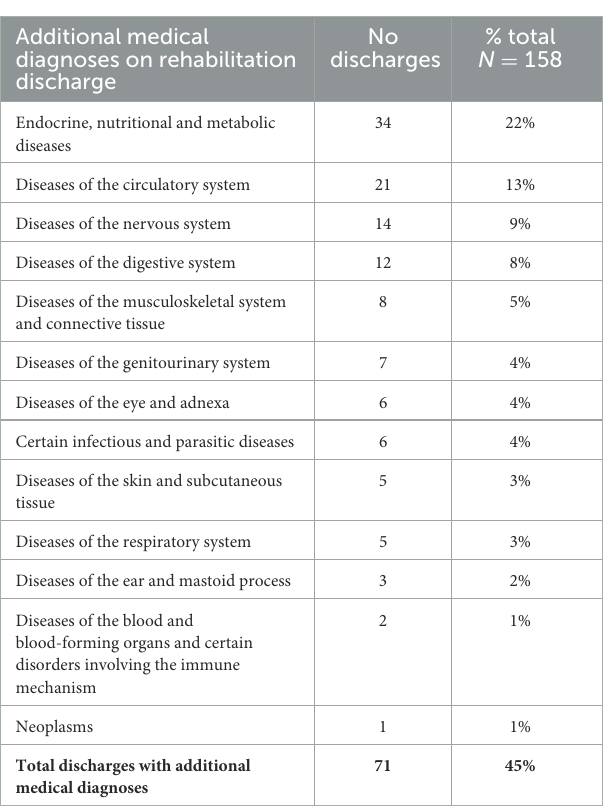
TABLE 5 Non-psychiatric